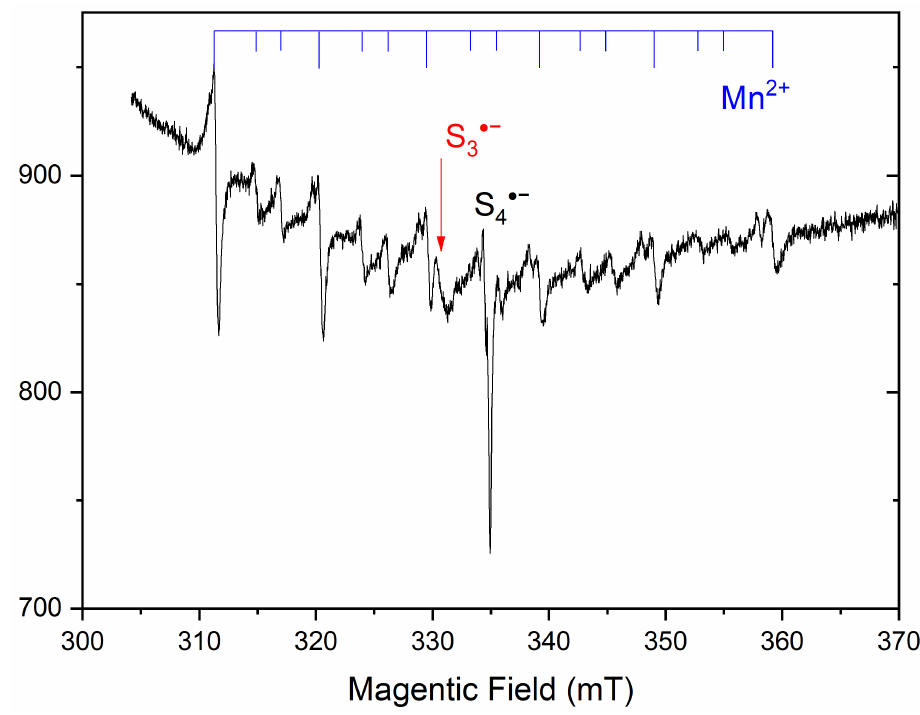
Figure 5. ESR spectrum of haüyne (Sample 1) measured at room temperature. The absorption bands with maxima at 0.65 and 0.88 eV are associated with the vi- brational modes of water in the studied mineral. The absorption bands with maxima at 2.05 and 2.38 eV, which impart a blue color to the studied mineral, can be associated with the presence of S 3●− radical anions, which are easily detected by ESR [4,5], while the lilac hue can be associated with the presence of S 4 molecules (red chromophore). In the sam- ples under study, the ESR signal characteristic of S 3●− (with g = 2.036) is practically not observed, which indicates a very low concentration of S 3●− radical anions in Sample 1. The absorption spectrum of S 3●− radical anions is characterized by a plateau at about 1.77 eV. However, the shape of the absorption spectrum of Sample 1 differs from the characteris- tic absorption of S 3●− of lazurite [4,5]. Thus, the absorption band at 2.05 eV is not related to S 3●− radical anions. On the other hand, in a number of works [40,41,52,53] it is noted that absorption bands at 2.05 and 2.38 eV, as well as a much less intense band about 1.33 eV, can be attributed to the absorption of trans - and cis -conformers of the neutral S 4 molecule. The authors of [40] calculated the oscillator strengths f for these conformals, which are equal to 0.07 and 0.047, respectively. The observed intense ESR signal with a g -factor of 2.002 can be attributed to the presence of some amount of O ●− radical anions (Figure 5). Previously, blue sodalite, in which a similar ESR signal and absorption spectrum were observed, was studied in [54,55], but the nature of the color of the mineral was not fully elucidated in this work. When this sample is heated above a temperature of 500 C, the studied sodalite loses its color. Along with this, an absorption band appears at 3.1 eV (400 nm) upon excitation, in which intense luminescence is observed with a maximum at 1.9 eV (650 nm). Such luminescence is characteristic of S 2●− radical anions [4]. 3.2. Crystal Chemistry, Isomorphism, and Thermal Conversions of Haüyne The IR spectra of initial and heated haüyne (Samples 2 and 5) are given in Figures 6–8. The spectra of initial samples contain bands of O–H stretching and bending vibra- tions of H 2 O molecules (in the ranges of 3300–3700 and 1640–1670 cm −1 , respectively), antisymmetric vibrations of the CO 2 molecules (at 2341 cm −1 ), asymmetric stretching